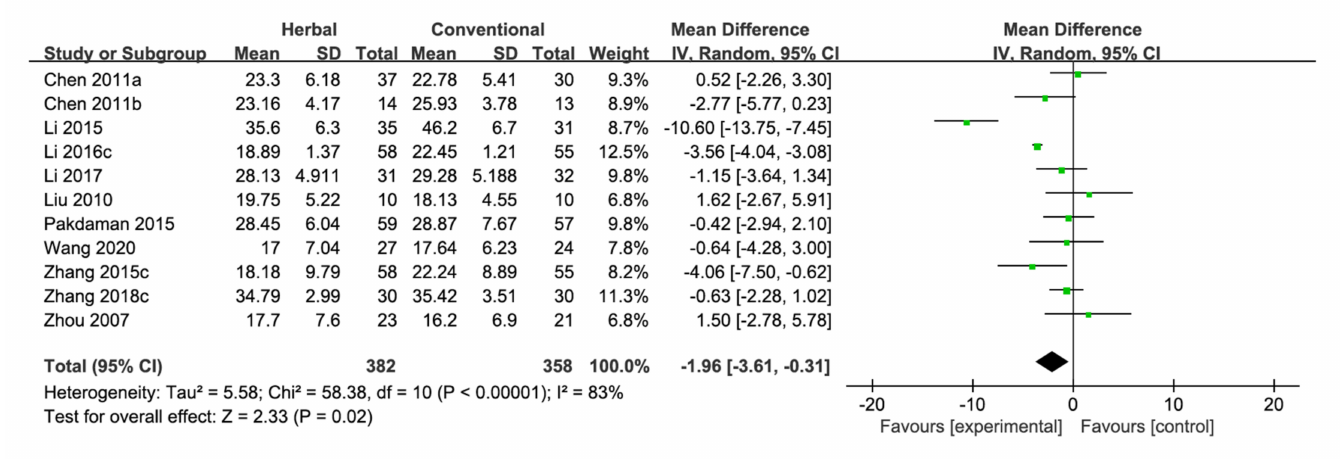
Figure 5. Forest plot for ADAS-cog: Herbal medicine vs. Conventional